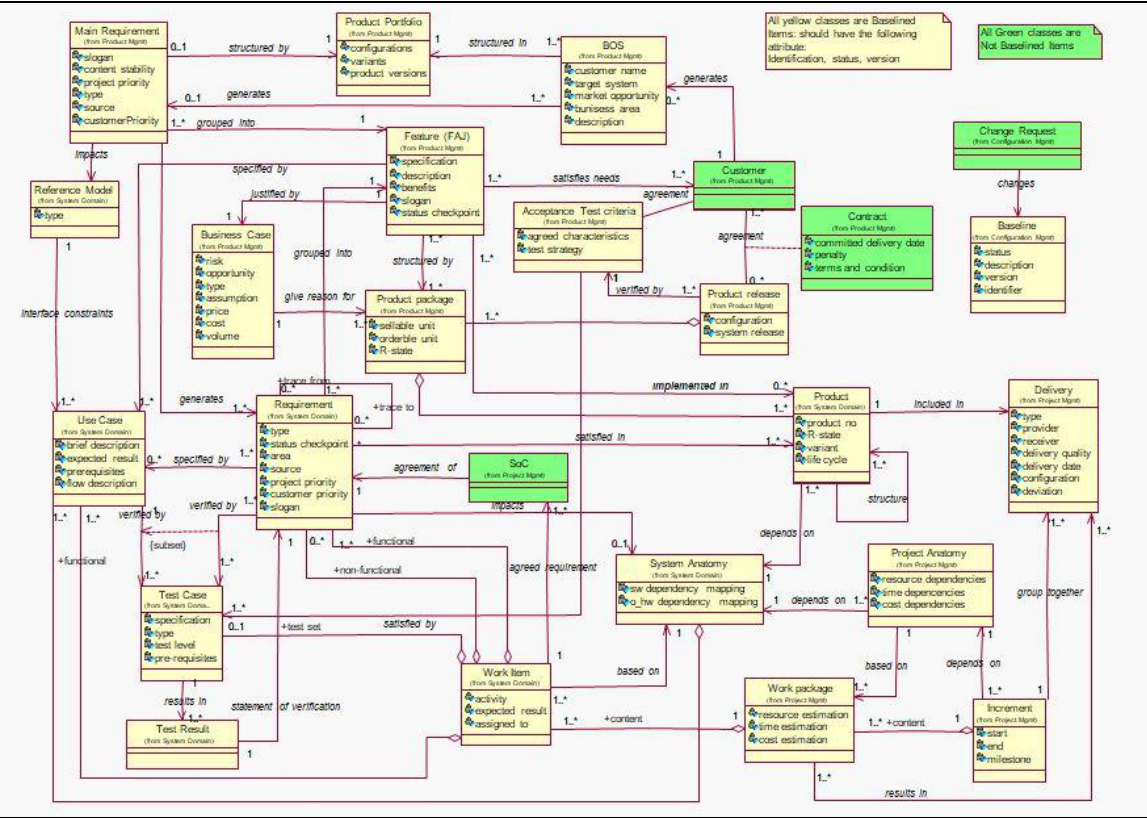
Figure 3. The B model –